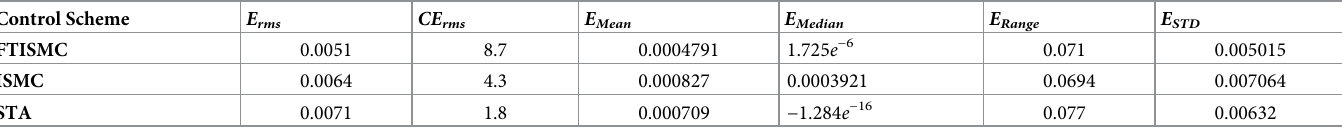
Table 4. Quantitative analysis of control schemes.